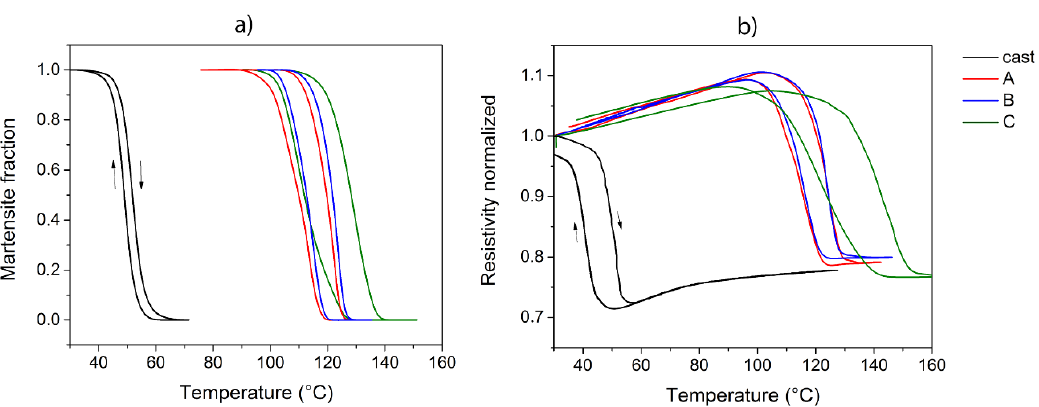
Figure8. ( a )Hysteresis cycles from DSC and ( b ) hysteresis cycles obtained from resistivity